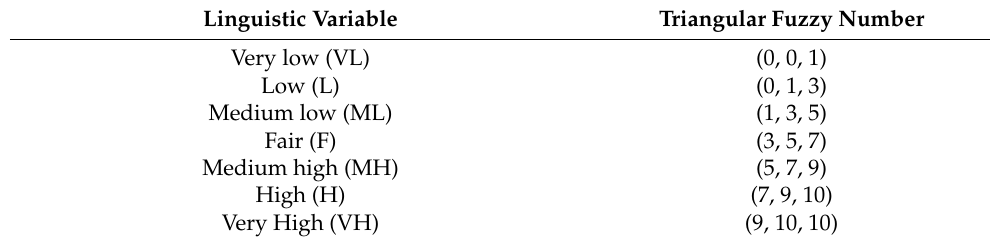
Table A2. Transformation rules of linguistic variables.